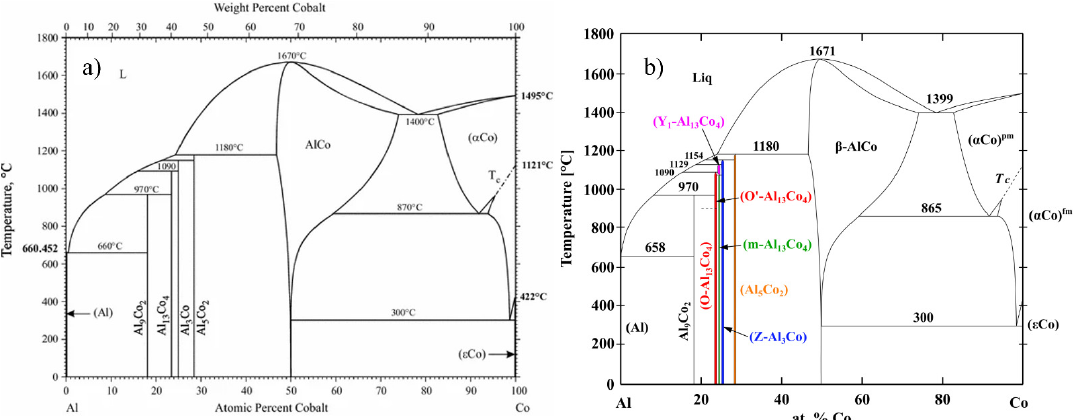
Figure 1. ( a ) Al-Co equilibrium phase diagram [46,47] (Reprinted with permission from [46]. Copy- right 2022, Springer Nature), ( b ) Revisited Al-Co equilibrium phase diagram [43,45,48]). Table 1. Crystallographic data for the intermetallic compounds present in the Al-Co system. Phase Space